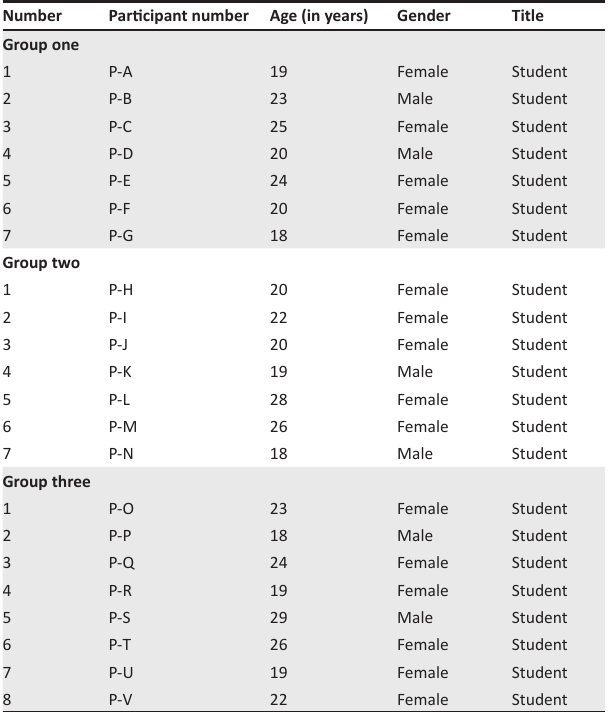
TABLE 1: Demographic information of